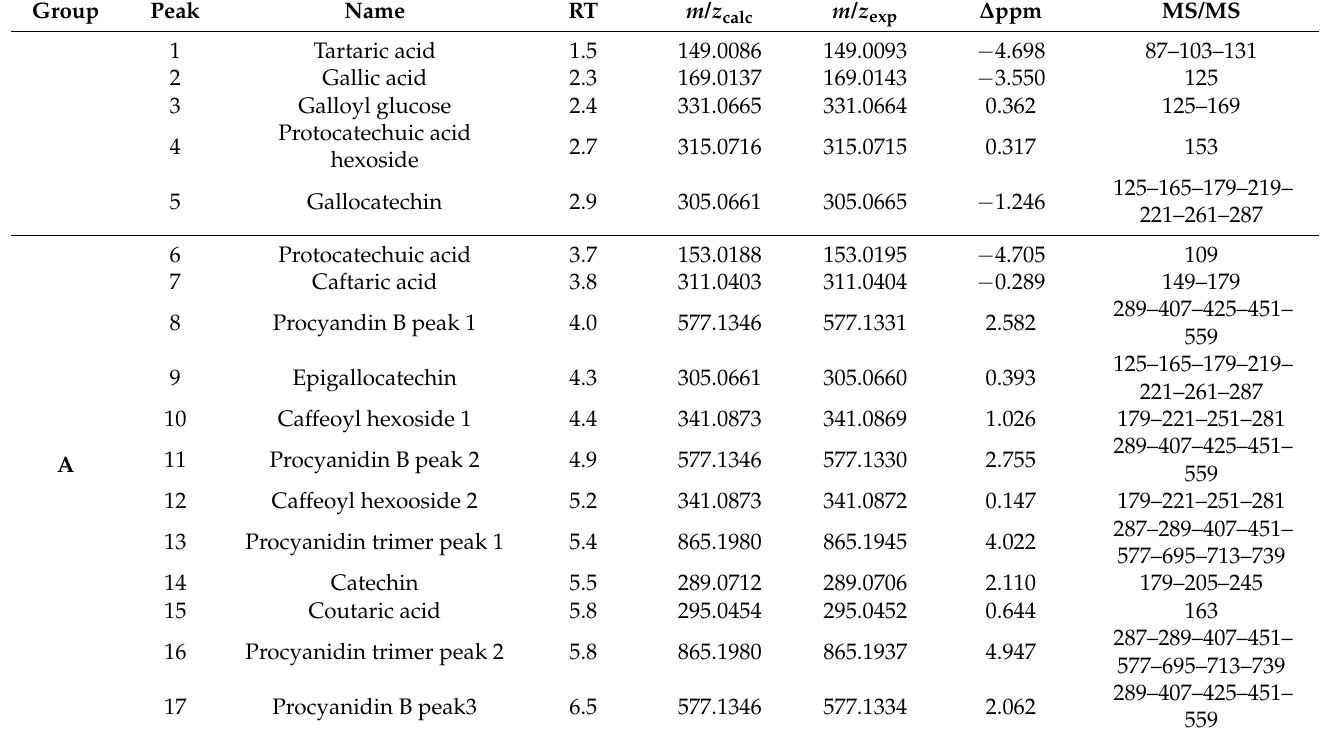
Figure 5. LC-ESI-(+)-MS total ion currents (TICs) in positive ion mode of the four extracts: ( A ) EtOH-H 2 O 70:30 (% v / v ); extract A; ( B ) water at 100 ◦ C, extract B; ( C ) water at 70 ◦ C extract C; ( D ) water at room temperature, extract D. Peaks are numbered on the basis of the RT and the peak assignment is reported in Table 6. Table 5. LC-ESI-(-)-MS identification (negative ion mode) of the EtOH-H 2 O extract constituents. The peak numbers refer to those reported in Figures